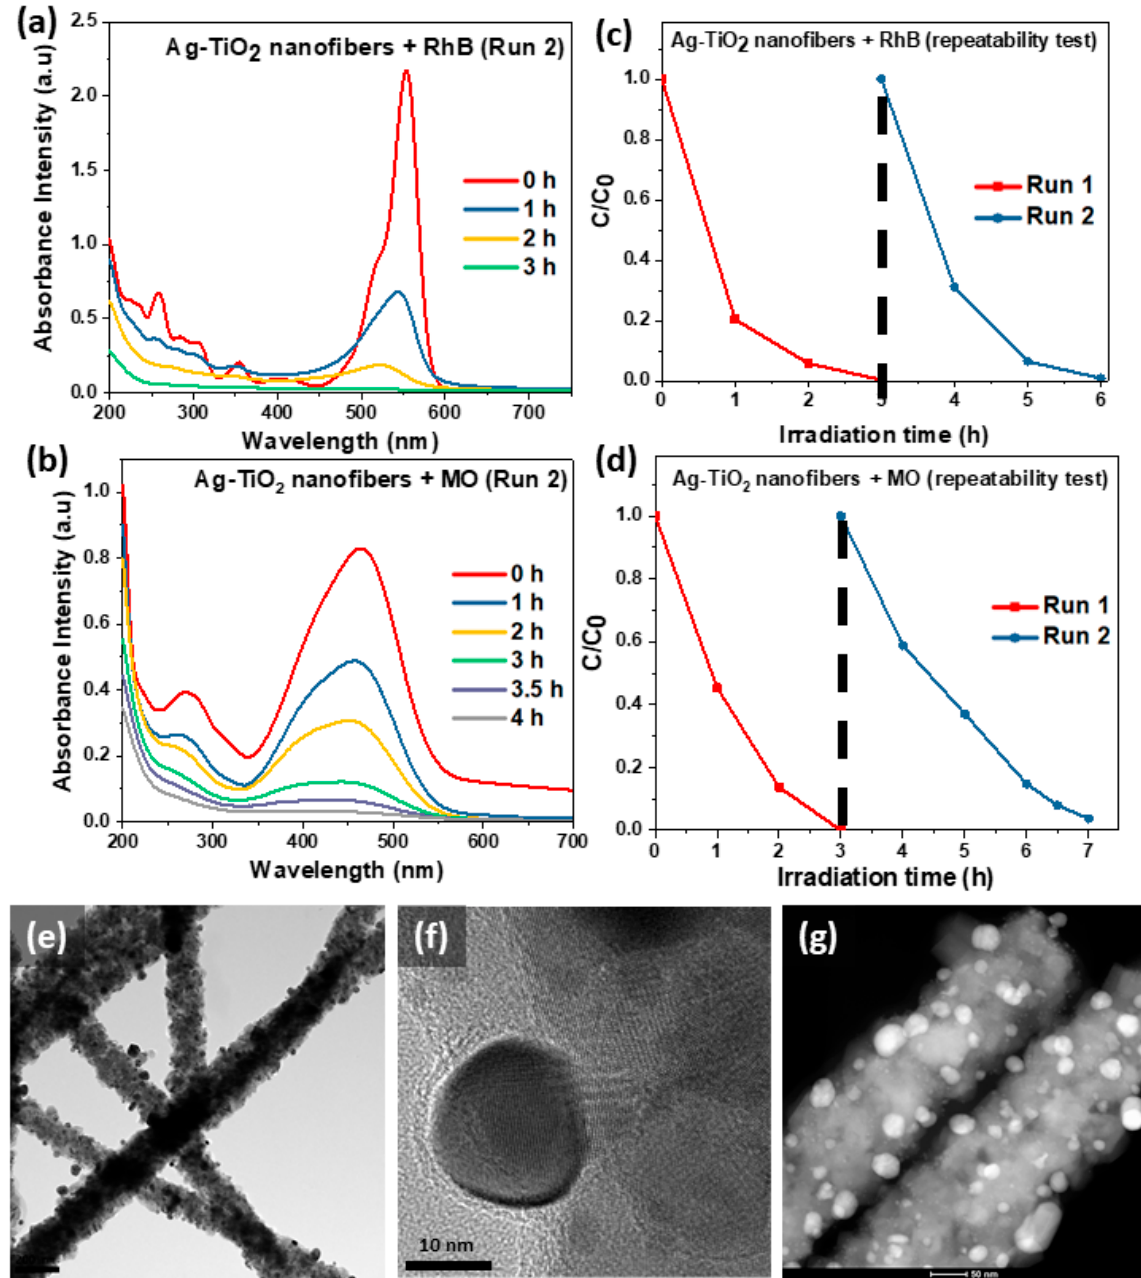
Figure 6. ( a – d ) UV-Vis spectra and their respective C/C 0 against irradiation time plots for the 2nd cycle of photodegradation of RhB and MO dyes with Ag-TiO 2 nanofibers; ( e,f ) TEM images of the Ag-TiO 2 nanofibers after the photodegradation study; ( g ) HAADF-STEM image of the Ag-TiO 2 nanofibers.